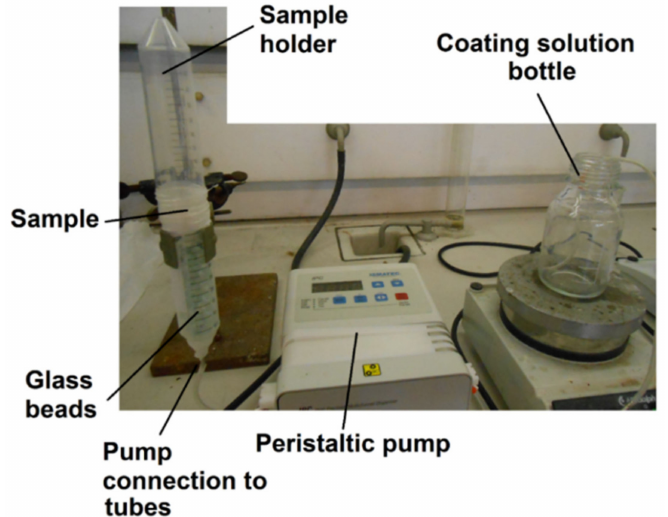
Figure 4. Coating apparatus used for the coating of cordierite supports with Ni/boehmite